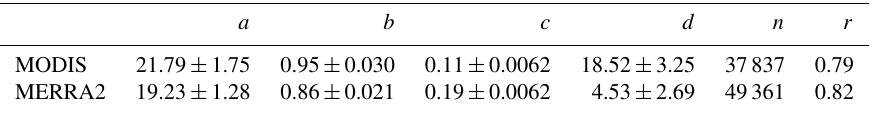
Table 2. The coefficients for Eq. 1 based on using CDNC SW retrieved by MODIS and inferred from MERRA2 sulfate. Coefficients and 95% confidence intervals ( a – d ) are listed for each. The number of observations used to train the model is listed as n . The correlation coefficient, r , between predicted and observed CLWP is also listed for each model. a